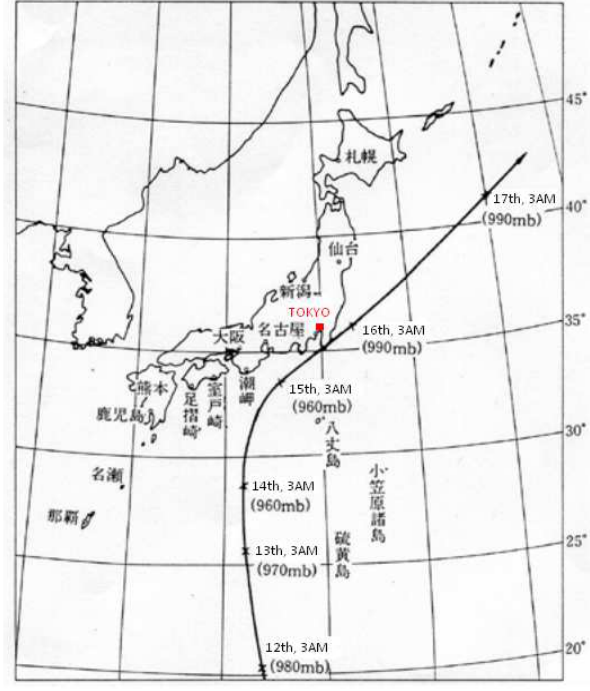
Fig 2: Diversion of streams in the Tone River catchment (modified from Tone River Research Group (1995) as Fig. 2. Diversion of streams in the Tone River catchment (modified cited in the National Research Institute for Earth Science and Disaster Prevention Report (2011)). The top map from Tone River Research Group (1995) as cited in the National shows the original configuration and the bottom the current system. Research Institute for Earth Science and Disaster Prevention Re- port, 2011). The top map shows the original configuration and the bottom the current system.